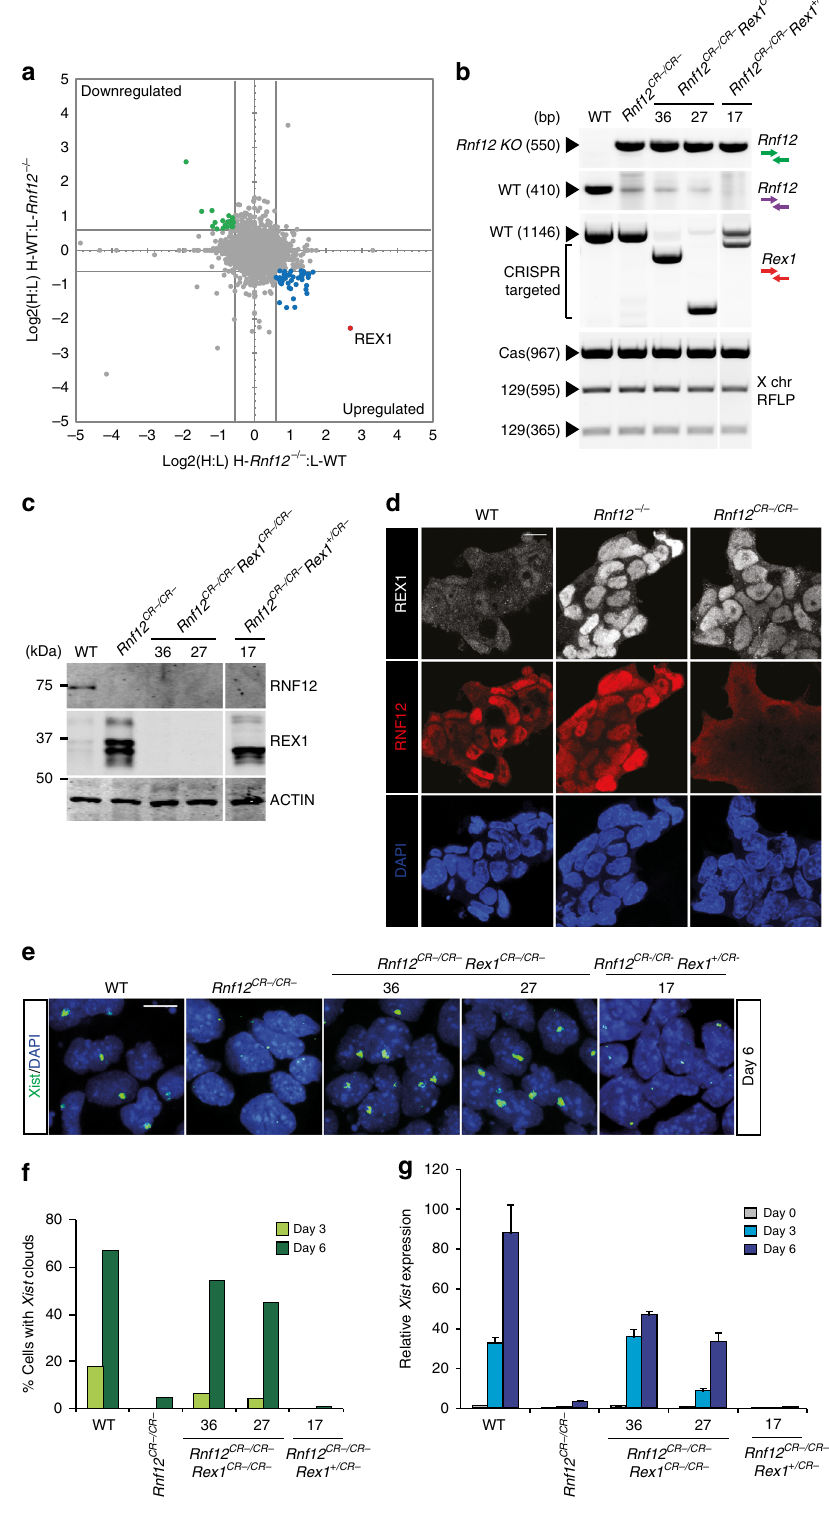
Rnf12 CR − /CR − :Rex1 CR − /CR − ESCs (Supplementary Fig. 4f), and not due to a defect in rXCI (Supplementary Fig. 4g). These results illustrate the crucial role for RNF12-mediated degradation of REX1 in the initiation of rXCI in vitro.